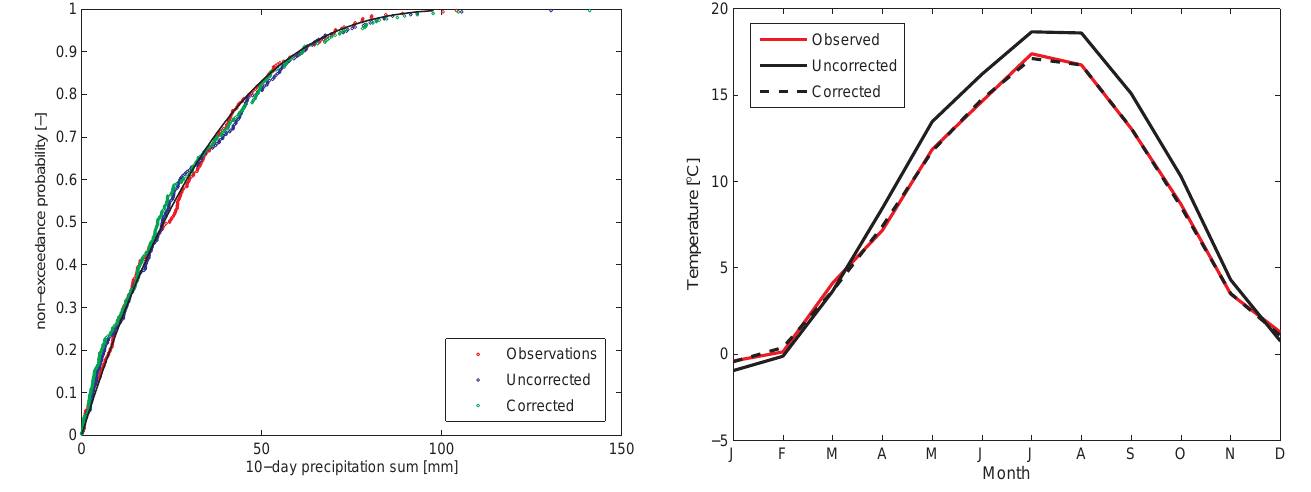
Fig. 10. Area-weighted monthly temperature [ ◦ C] over the entire Rhine basin for the period 1979–1995. Results are shown for the observations and the uncorrected and corrected